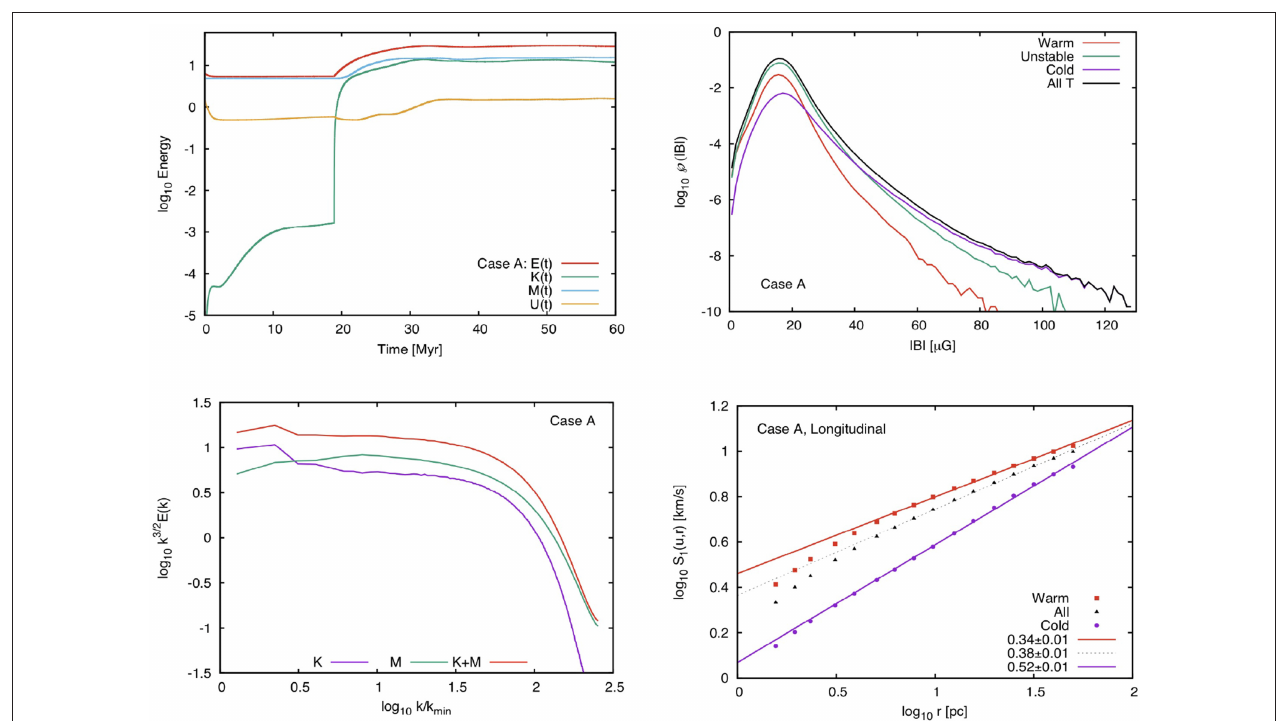
FIGURE 4 | Results of simulations of ISM magnetized turbulence performed by Kritsuk et al. (2017). (Top-left panel) Shows the total, kinetic, magnetic and internal energies as a function of time. (Top-right panel) Displays the magnetic field PDF in the warm, unstable and cold phases. (Bottom-left panel) Portrays the powerspectra of the kinetic, magnetic and total energies while (bottom-right panel) shows the structure functions of the velocity in the various phases of the